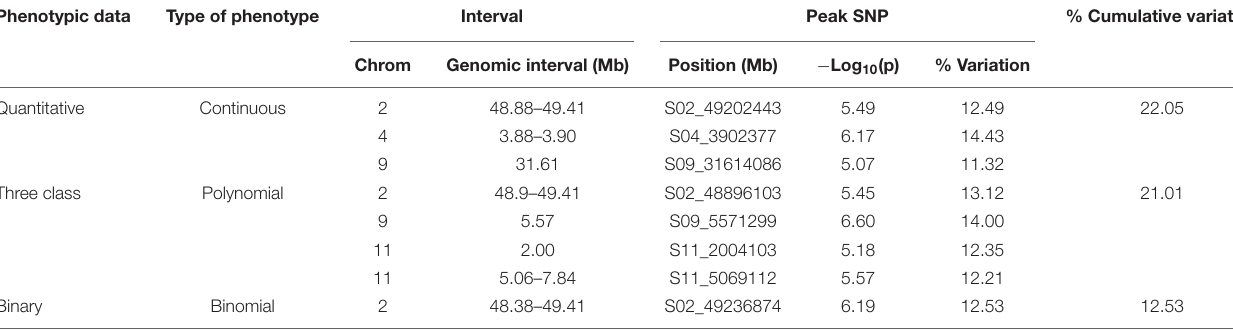
TABLE 4 | GEMMA GWAS results of ADP genotypes for the three phenotypic scoring systems.